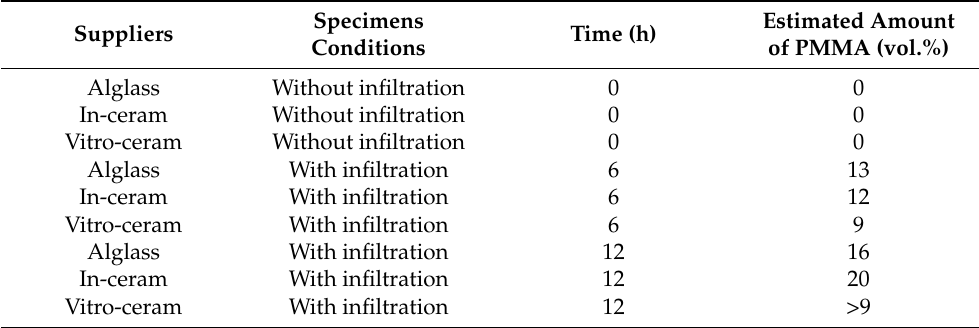
Table 1. Summary of conditions for preparation of samples, infiltration time and the estimated amount of PMMA (vol.%)